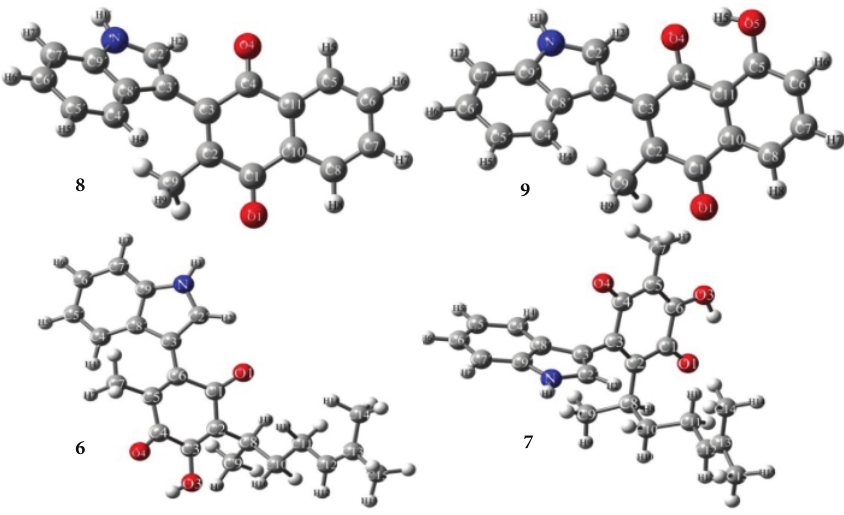
Figure 2: Optimized geometry of the indolylquinones through